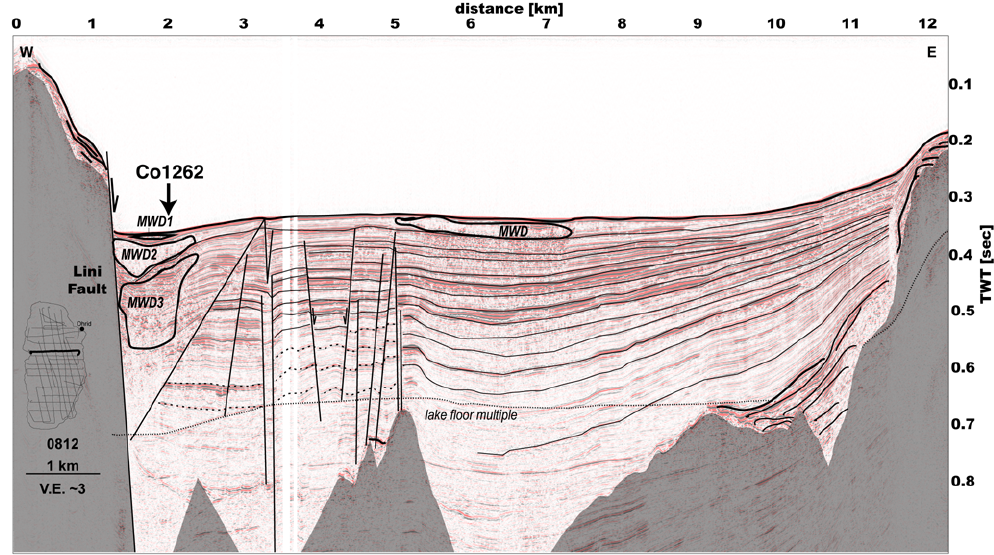
Fig. 2. Interpreted multichannel seismic profile taken by a Mini GI Gun across Lake Ohrid with the Lini Fault in the west. Grey parts indicate bedrock. The arrow indicates coring location Co1262. Transparent sediment bodies indicate mass wasting deposits